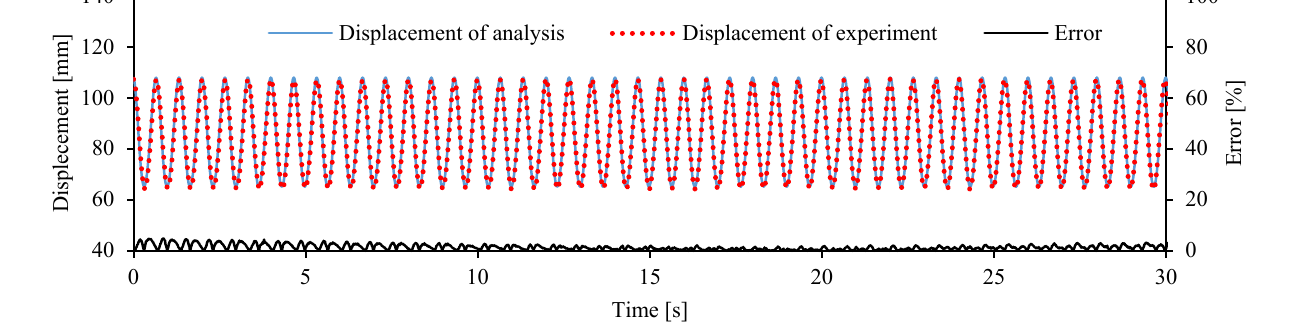
Figure 9. Graphs of voltage-based analysis voltage vs. time for confirming damping coefficient. 3. Results To confirm the adequacy of the analytical accuracy, measurement experiments were performed for three experimental cases: (1) random signal excitation, (2) periodic signal excitation, and (3) simultaneous excitation of both excitation signals (i.e., random and pe- riodic signals). The natural frequencies f 1 at the stable vibration points on both sides of the bi-stable vibration system and f 2 at the central unstable vibration point are determined using Equa- tions (25) and (26), respectively.